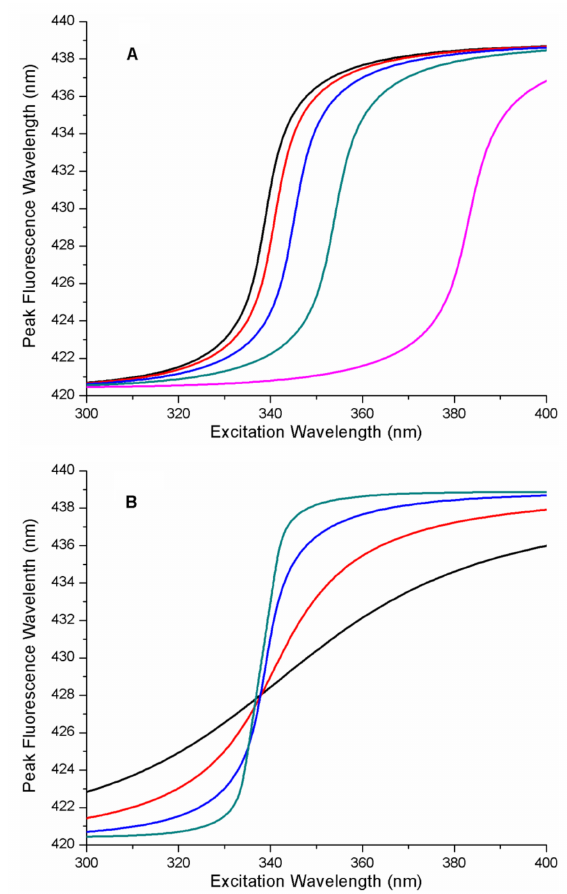
Figure 2. Influence of protein–ligand free energy landscape on red-edge excitation spectroscopy (REES) plots. ( A ) REES curves for a linear ramp free energy landscape (b = 1). Plots from left to right represent the effect on REES of increasing free energy gradient (A = 0.0025, A = 0.005, A = 0.01, A = 0.02, A = 0.05 eV). All other parameters were fixed ( x GS = 0.1 eV 0.5 , b = 1). The photo-physical parameters for the ligand, L were fixed ( x CT = 0.89 eV 0.5 , κ = 1, ∆ G CTGS 0 = 3.346 eV, ∆ G CTGSN = 3.223 eV). Plots were generated with the specified parameters using Equations (13) and (14) from the theory section (the range of x was from − 1 to 2). ( B ) REES curves for a linear ramp free energy landscape (b = 1). Plots represent the effect, on REES, of increasing spacing between microstate free energy surfaces along the reaction coordinate from shallowest to steepest near the transition mid-point ( x GS = 0.025, x GS = 0.05, x GS = 0.1, x GS = 0.2 eV 0.5 ). All other parameters were fixed (b = 1, A = 0.0025 eV). The photo-physical parameters for the ligand, L were fixed ( x CT = 0.89 eV 0.5 , κ = 1, ∆ G ∆ G CTGS0 = 3.346 eV, CTGSN = 3.223 eV). Plots were generated with the specified parameters using Equations (13) and (14) from the theory section (the range of x was from − 1 to